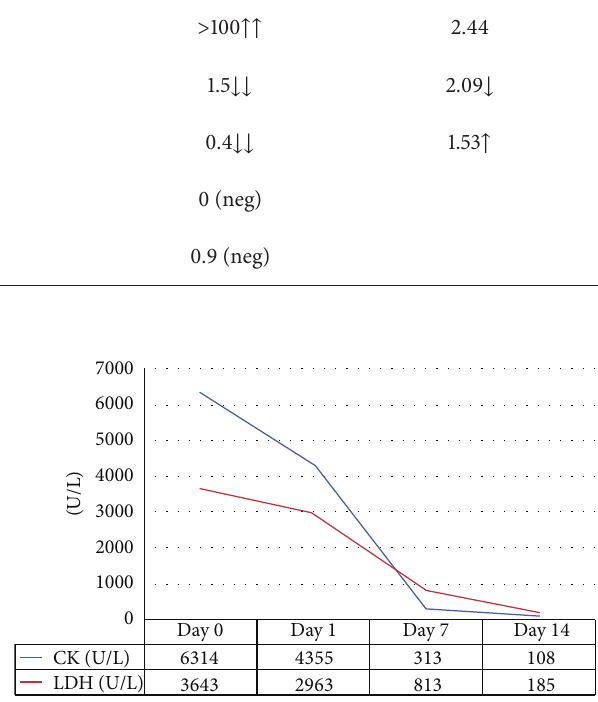
Figure 1: Rhabdomyolysis parameters of the patient during the hospital